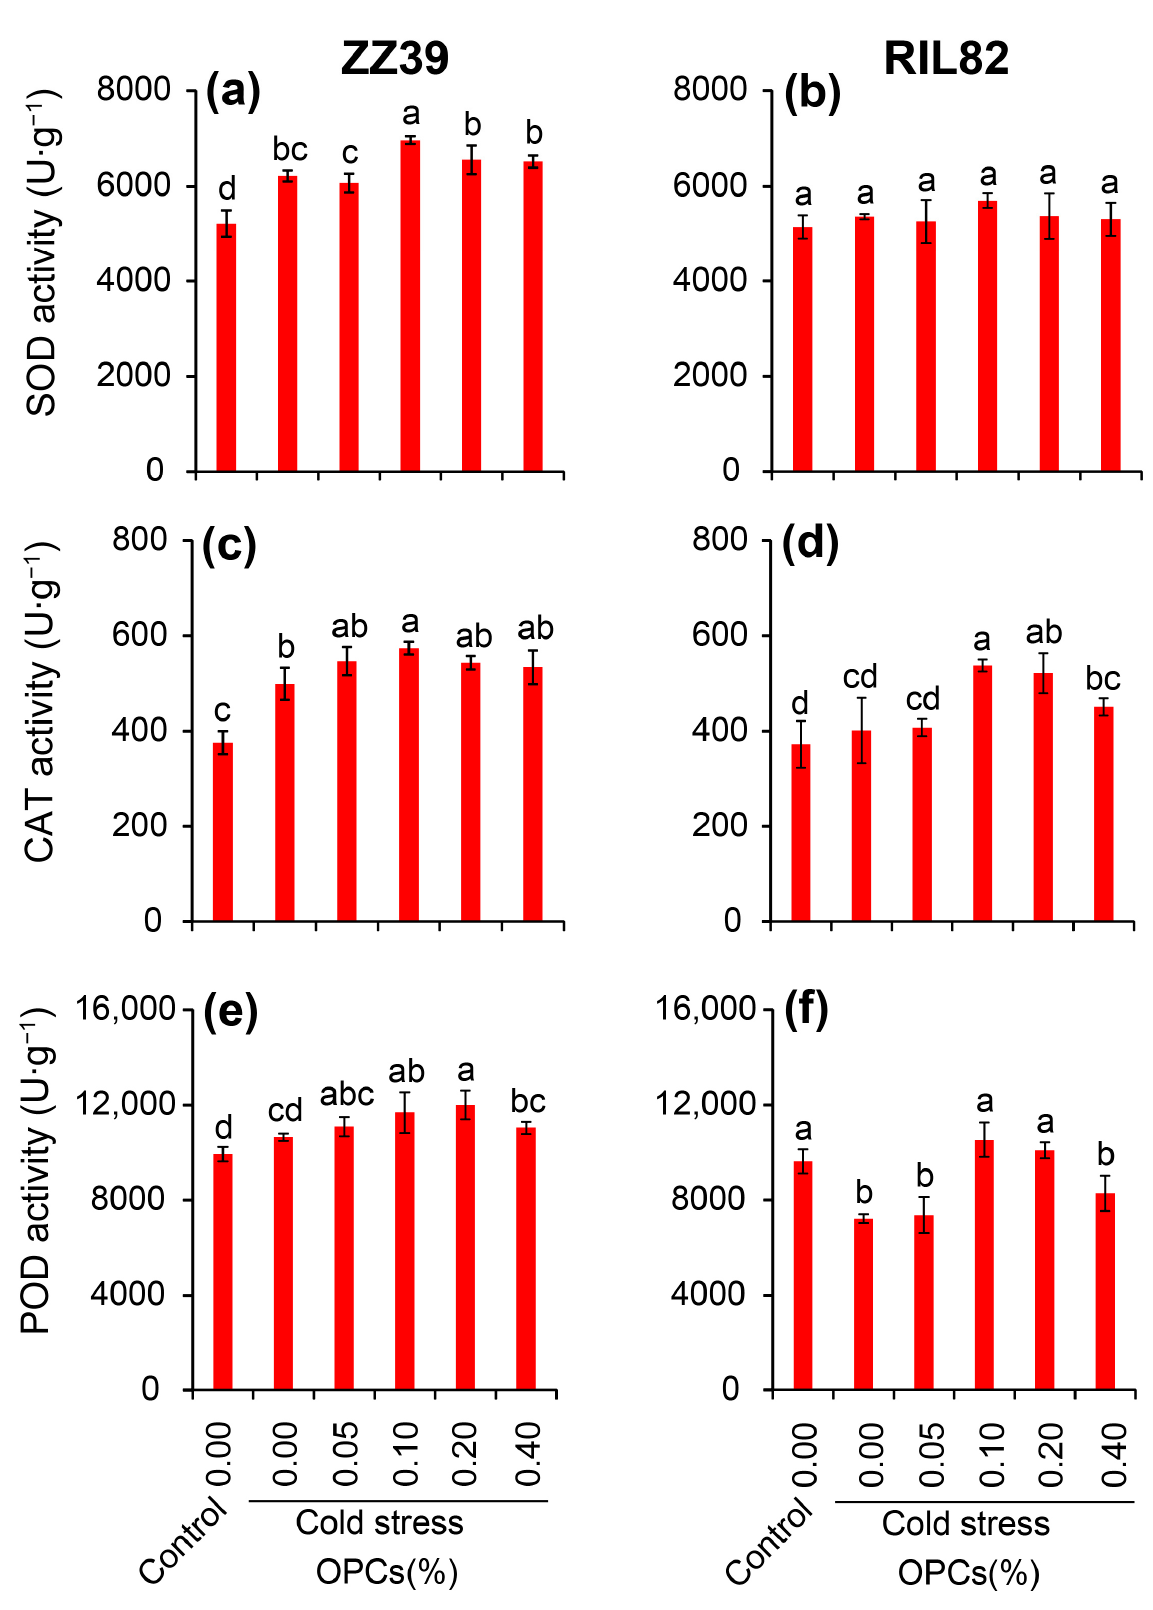
Figure 5. Effect of OPCs on antioxidant enzyme activities in rice leaves under cold stress. ( a , b ), SOD activity; ( c , d ), CAT activity; ( e , f ), POD activity. OPCs, oligomeric proanthocyanidins; SOD, super- oxide dismutase; CAT, catalase; POD, peroxidase. Vertical bars denote standard deviations ( n = 3). Different letters indicate significant differences among the control and cold stress treatments within a genotype by two-way analysis of variance (temperature and treatment) ( p < 0.05).